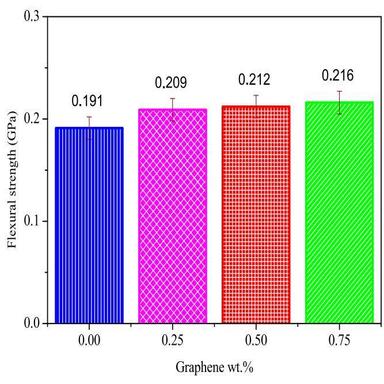
Flexural strength for GFRP composites with various wt% of graphene.